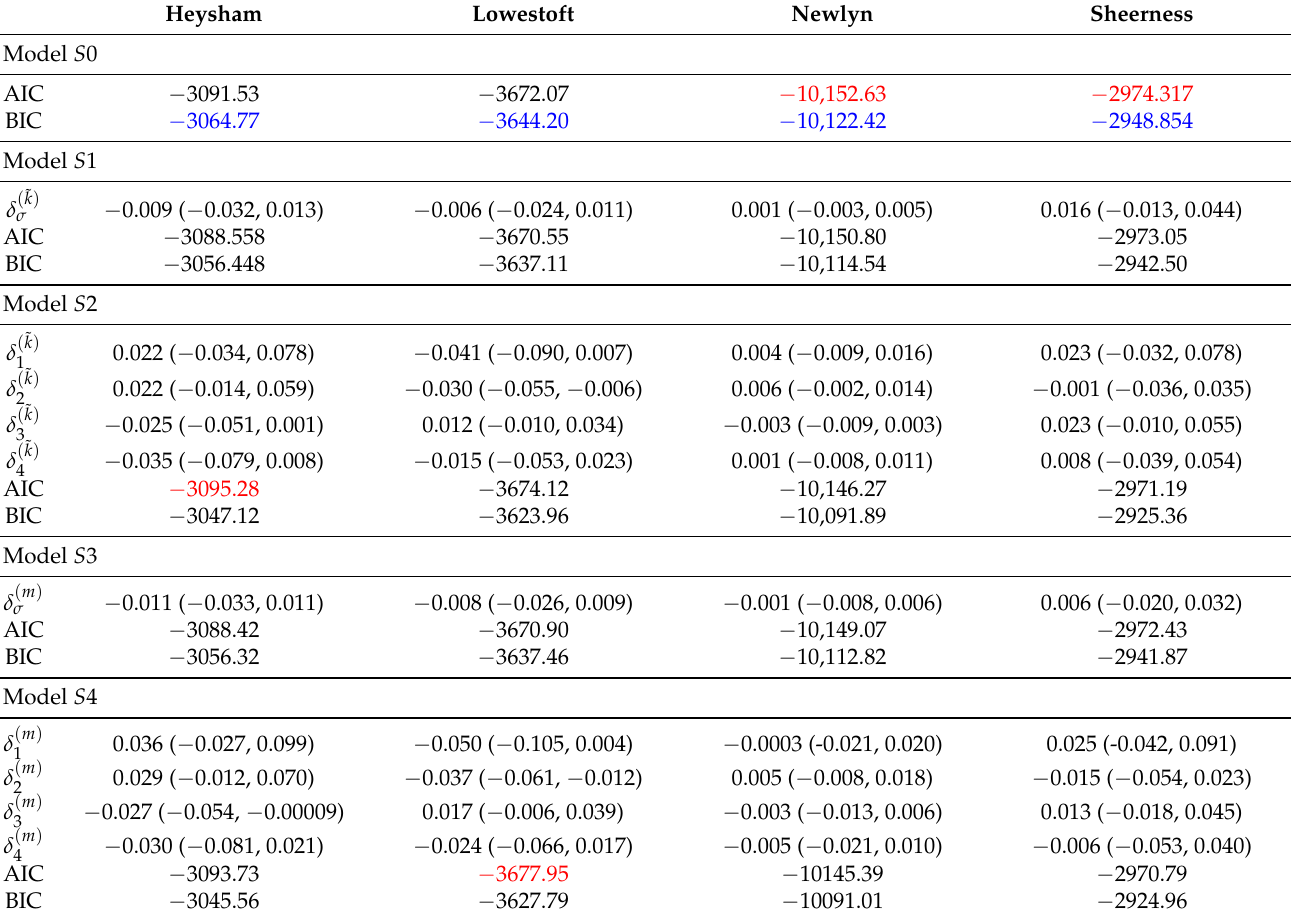
Table 3. Parameter estimates for the Models S 1-4 with AIC and BIC scores for each model fit at each site (including Model S 0). The minimum AIC and BIC scores are highlighted in red and blue, respectively, for each site. The 95% confidence intervals are given in parentheses for parameter